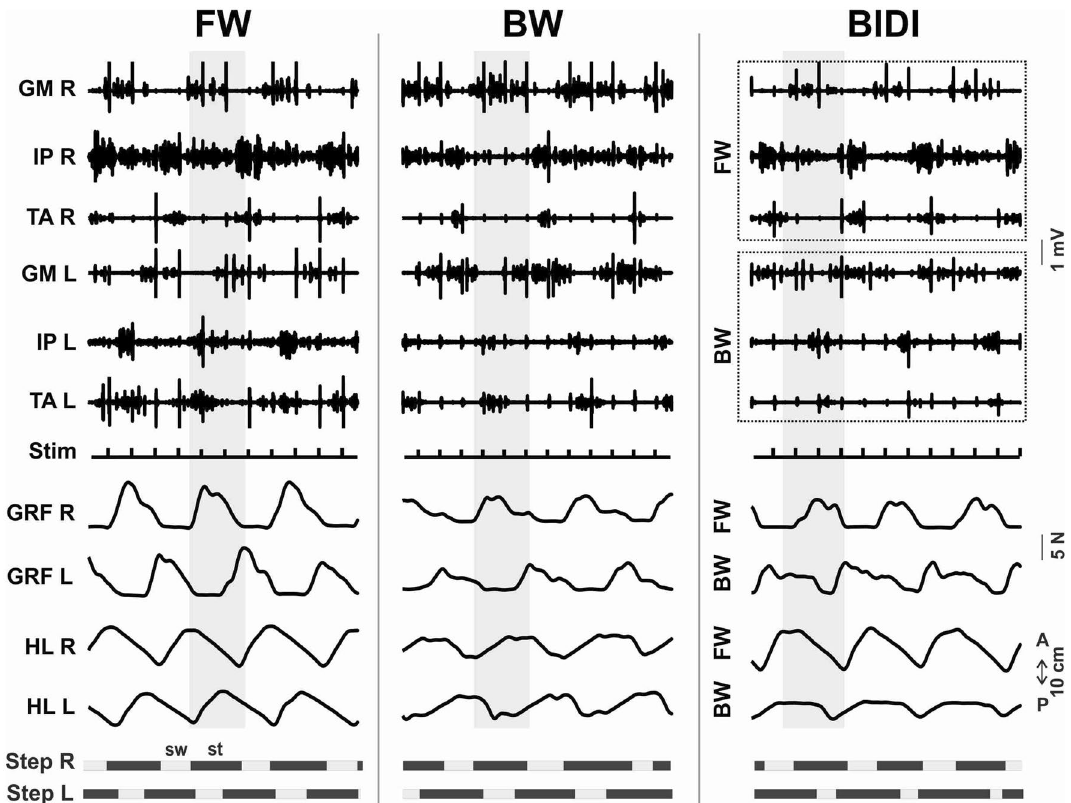
Figure 2. EMG pattern of the BIDI stepping in comparison to unidirectional FW and BW. Examples of left and right ground reaction forces (GRF L, GRF R) and EMG pattern of left and right mm. iliopsoas (IP), tibialis anterior (TA) and gastrocnemius (GM) during subsequent stepping of left and right hindlimbs (HL L, HL R). The muscle activity of hindlimbs moving forward and backward during BIDI are marked by dotted rectangles. Shaded gray areas marked the activity during one stance phase of the right